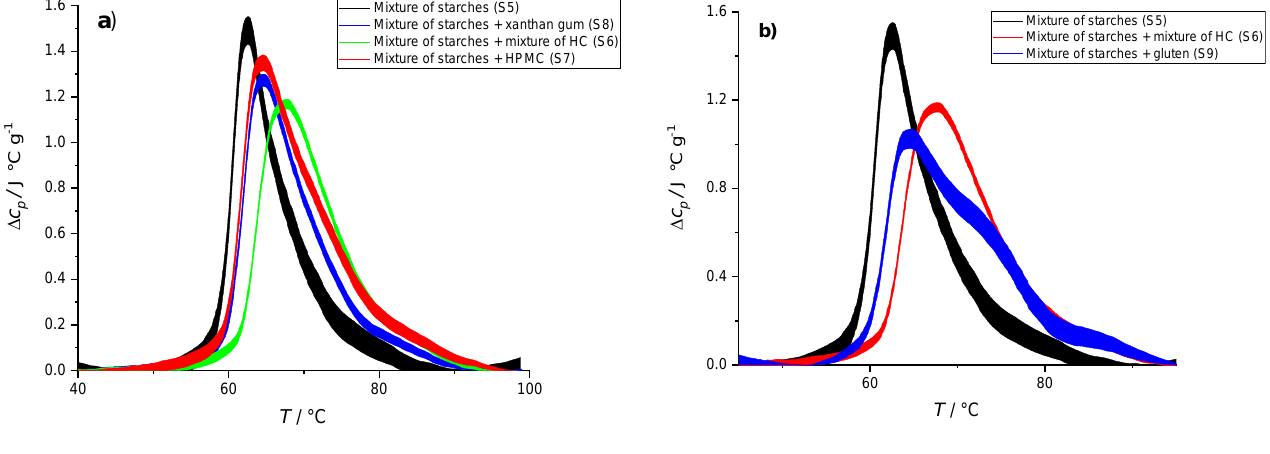
Figure 5. DSC thermograms of different mixtures of starch (potato and corn starch in ratio 85:15), xanthan gum, and HPMC in water. ( a ) Thermograms of 50% suspension of potato and corn starch mixture in 85:15 ratio (black line, S5), 38% suspension of starch mixture with HC mixture (4% xanthan gum and 8% HPMC) (green line, S6), 42% suspension of starch mixture with 8% HPMC (red line, S7), and 45% suspension of starch mixture with 5% xanthan gum (blue line, S8). ( b ) Thermograms of 50% suspension of potato and corn starch mixture in 85:15 ratio (black line, S5), 38% suspension of starch mixture with HC mixture (4% xanthan gum and 8% HPMC) (red line, S6), and 38% suspension of starch mixture with 12% gluten (blue line, S9). The lines represent averages of three independent experiments ( n = 3) and the line thickness corresponds to SD. All concentrations are given as ( w / w ). Table 5. Transition enthalpies ( ∆ H tr ) and temperatures ( T tr ) obtained from the thermograms in Figure 5. Starch